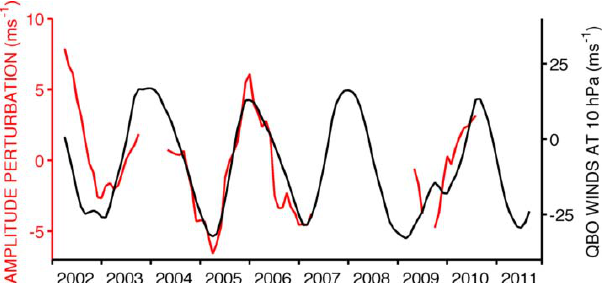
Fig. 13. Perturbations in meridional diurnal tide amplitudes (cal- culated by subtracting the composite-year monthly mean from each individual month) at heights near 84km for 2002–2011 over Ascen- sion Island (red line). Also plotted are the QBO background winds at 15hPa (black line). The diurnal tidal amplitude perturbations and background winds are smoothed with a seven-month running mean. Note the two different axes, with the red axis on the left correspond- ing to the diurnal amplitude perturbations and the black axis on the right corresponding to the QBO line. Fig. 14. Correlation between meridional diurnal amplitude pertur-